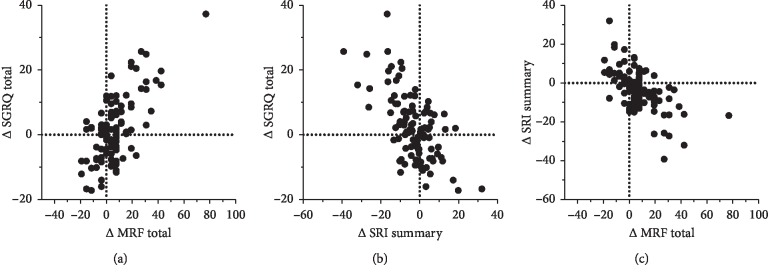
Scatter plots between the changes (Δ) in each HRQL measure. (a) The SGRQ total versus the MRF-26 total; (b) the SGRQ total versus the SRI summary; and (c) the SRI summary versus the MRF-26 total.